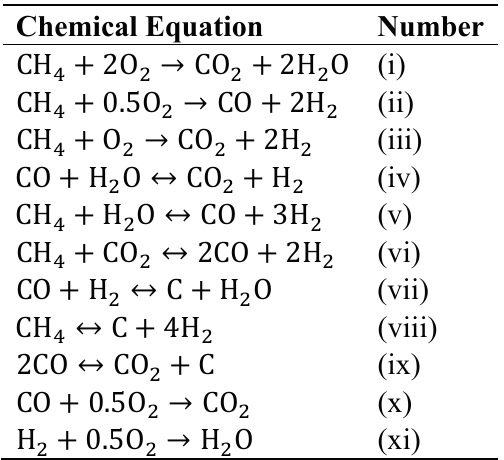
Table 1. Complete equation system for POX of methane [10].